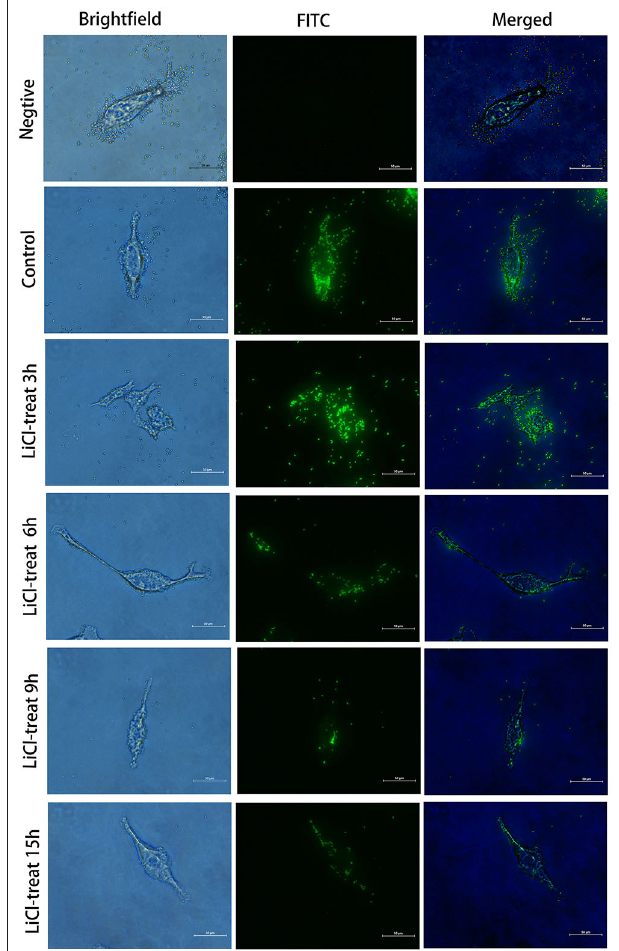
FIGURE 3 | Fluorescence microscope observation of the HCT116 cells adhesion by L. plantarum HC-2. After being labeled with fluorescein isothiocyanate (FITC), the bacteria were washed with sterile phosphate-buffered saline (PBS) 5 times, and the concentration of the bacteria was adjusted to 10 8 CFU/mL and added into the cell culture well. After 2h of incubation, the cells were washed with sterile PBS 3 times. Then, the cells were fixed with paraformaldehyde, and observed under the fluorescence